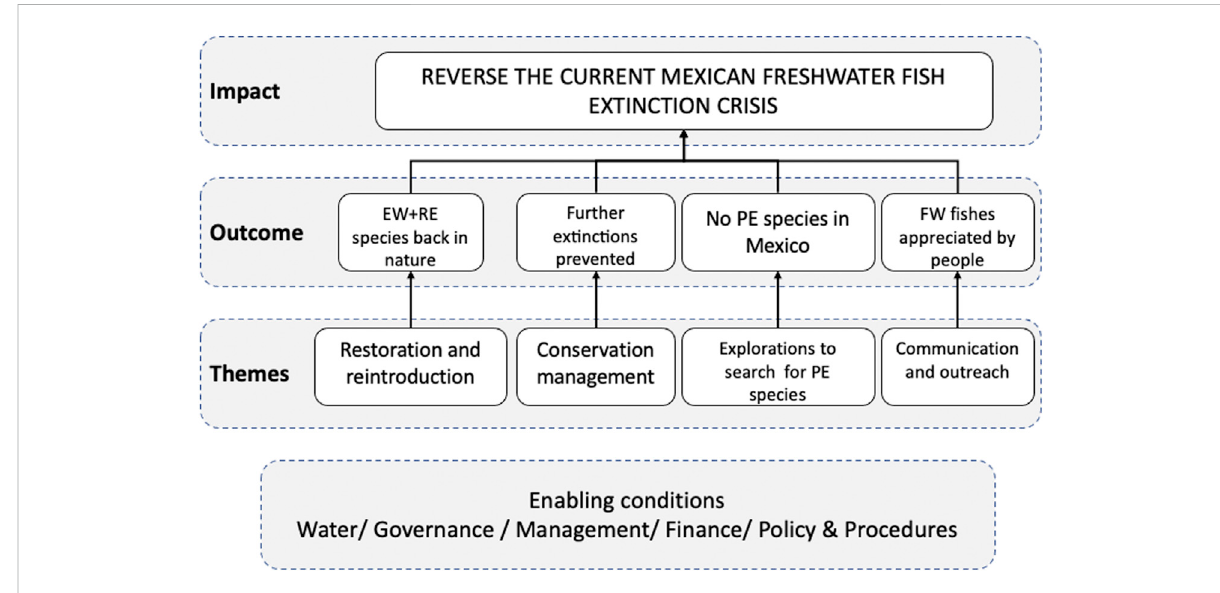
FIGURE 1 High level ToC to reverse the current Mexican freshwater fi sh extinction